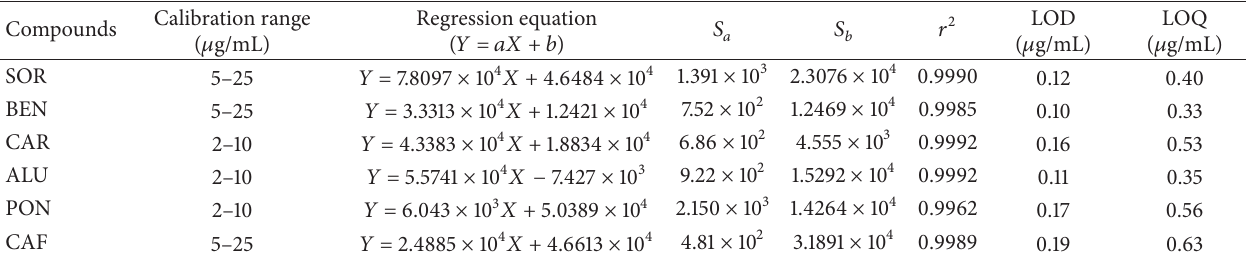
Table 4: The important parameters of the calibration equations for the proposed HPLC method for simultaneous determination of potassium sorbate (SOR), sodium benzoate (BEN), carmoisine (CAR), allura red (ALU), ponceau 4R (PON), and caffeine (CAF). Compounds